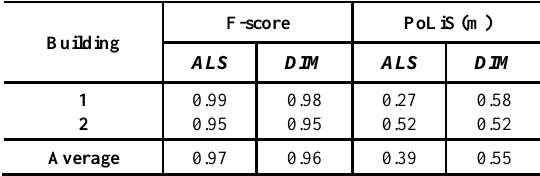
Table 4. Building roof shape extraction